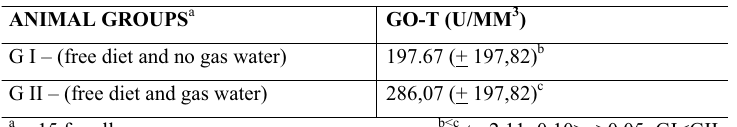
TABLE 1 – Medium values of glutamic oxaloacetics transaminase (GO-T) in international units through cubic millimeters of blood (U/mm3) and respective standard deviations, in the experimental groups